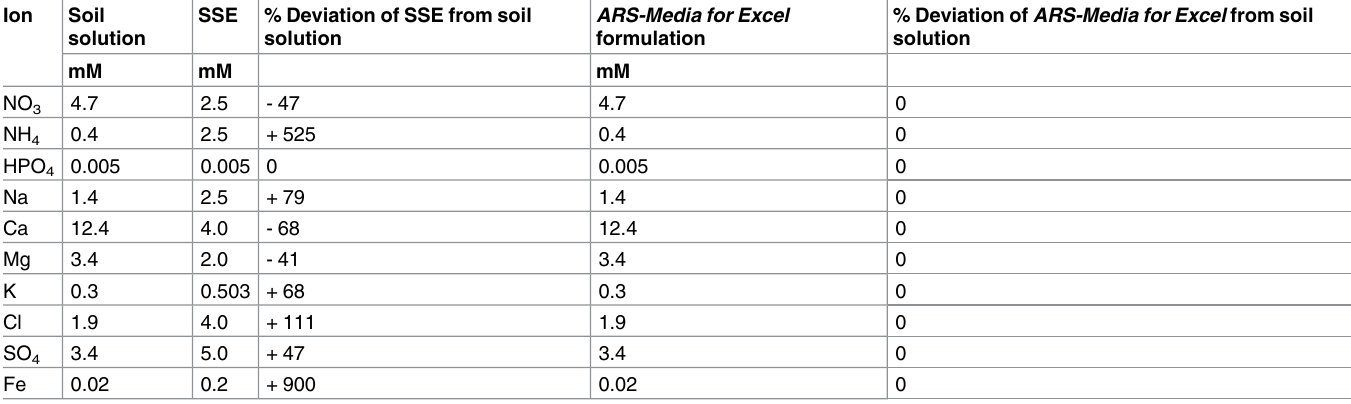
Table 2. Ionic compositions of the “soil solution equivalent” (SSE) and ARS-Media for Excel formulation and how each compares to the ion lev- els of the target soil solution. Ion Soil SSE % Deviation of SSE from soil solution solution